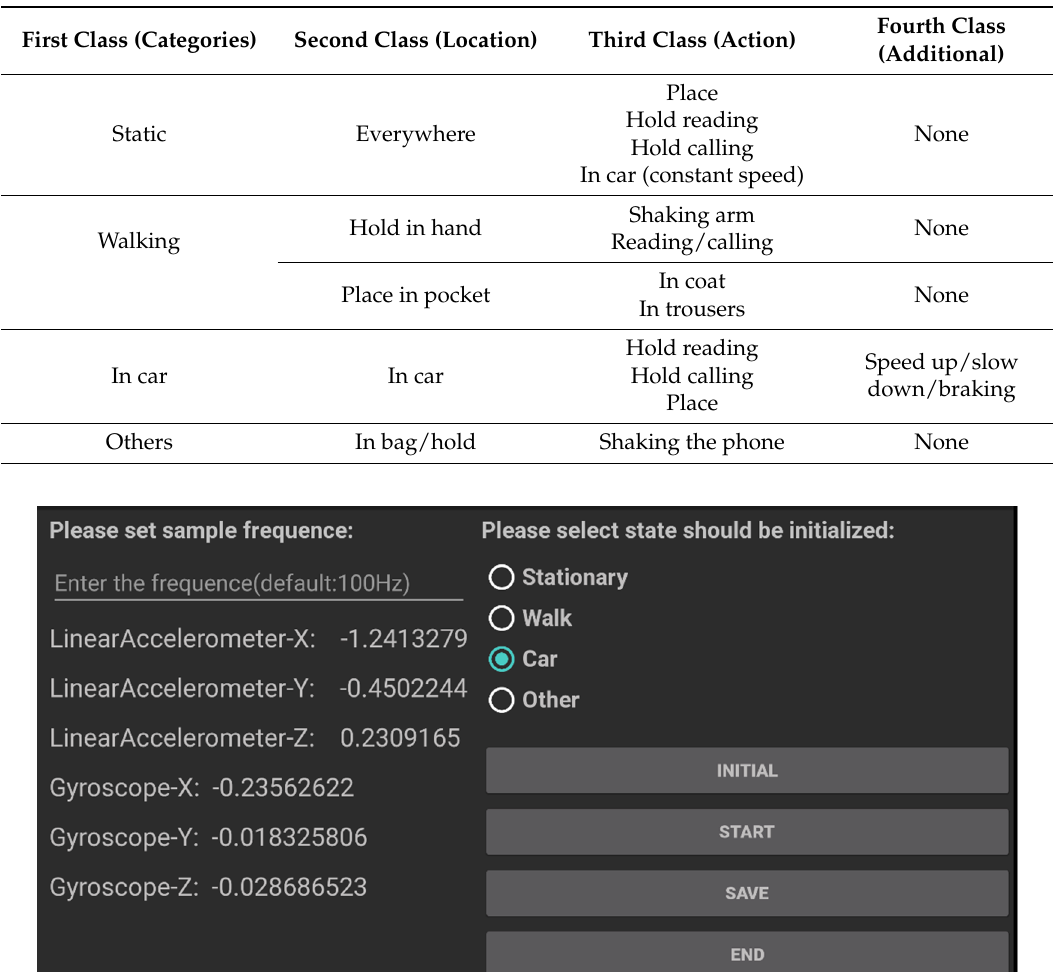
Table 2. Data collection types.